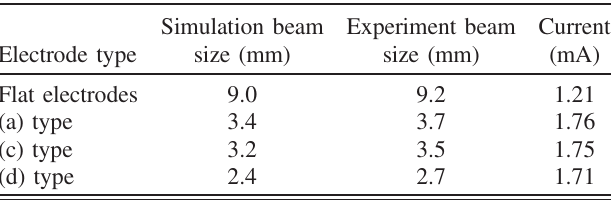
TABLE I. Comparison of simulation and experimental results of beam spot size at tritium targets with different electrodes (The currents are all experimental